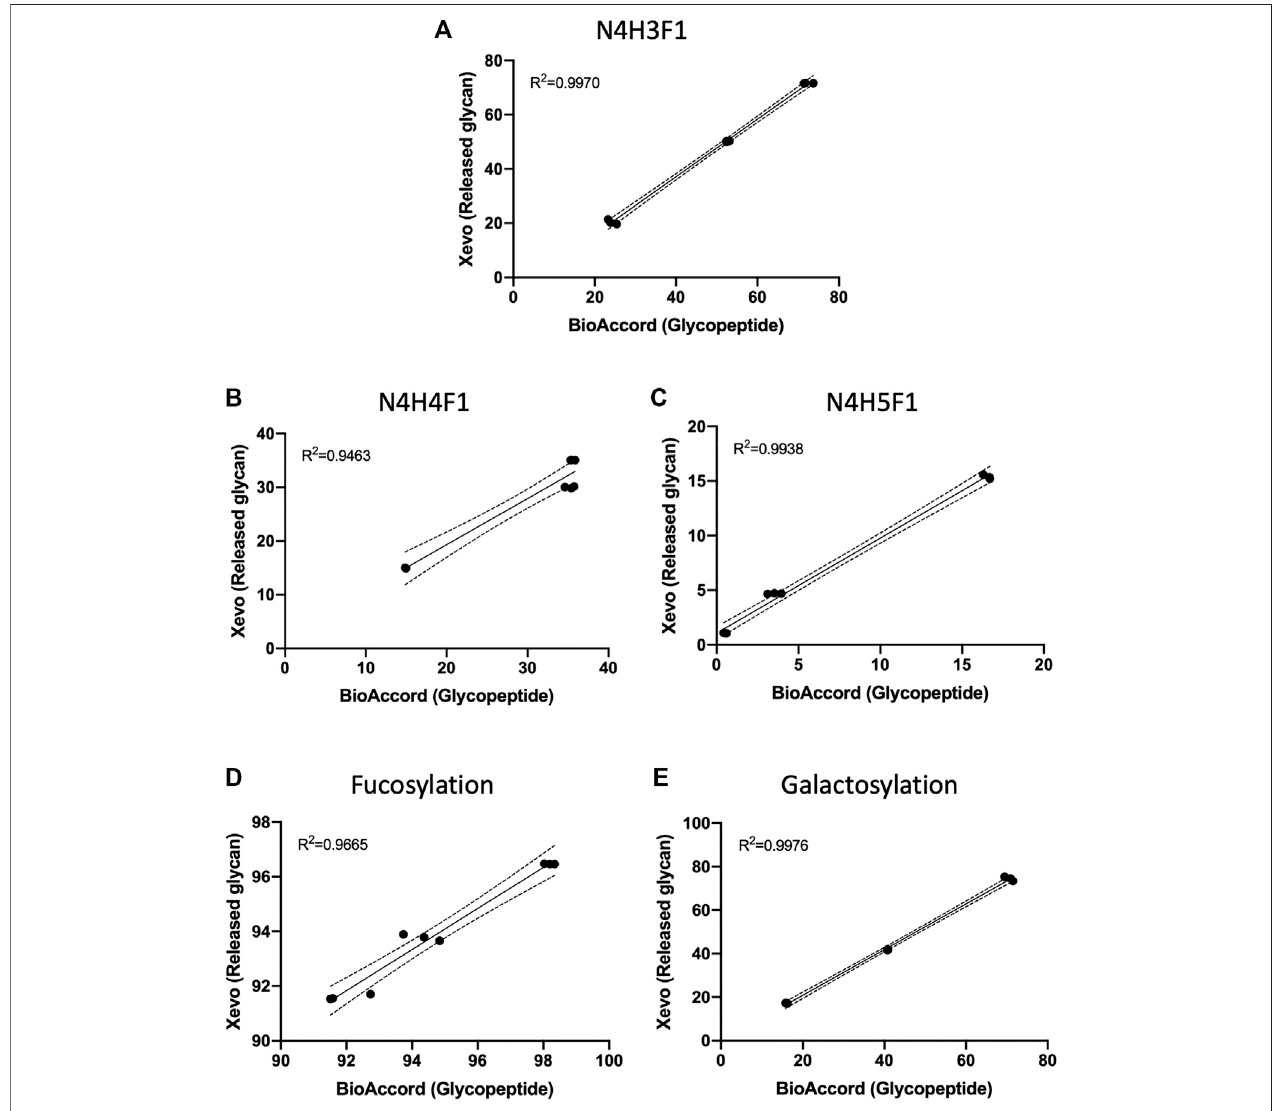
FIGURE 6 | Data of the three most abundant glycans, (A) N4H3F1, (B) N4H4F1, and (C) N4H5F1, and glycosylation attributes, (D) fucosylation and (E) galactosylation, acquired and analysed usingXevo G2-SQTof work fl owwerehighly correlated toBioAccordLC-MS systemwork fl ow. (Linearregression analysis,three replicates per antibody group, n (cid:2)